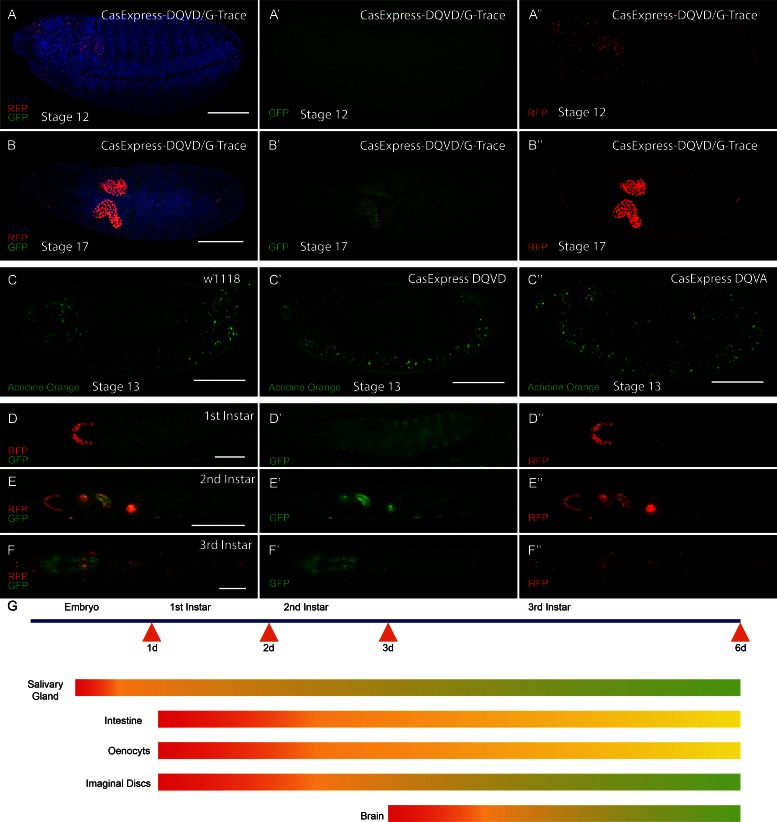
CasExpress activation in embryos and larvae.(A–B”) RFP and GFP expression in Drosophila embryos (A–A”) stage 12, (B–B”) stage 17. (C–C”) Acridine orange detection of apoptotic cells in stage 13 embryos of the indicated genotypes. (D–D”) 1st instar larva, (E–E”) 2nd instar larva and (F–F”) 3rd instar larva. (G) A schematic summarizing of GFP and RFP expression in above stages. Red represents RFP expression. Green represents GFP. Yellow/Orange indicates either a mixture of GFP positive and RFP positive cell populations or the presence of cells expressing both. Scale bars represent: 100 μm (A–C); 200 μm (D); 400 μm (E); and 600 μm (F).